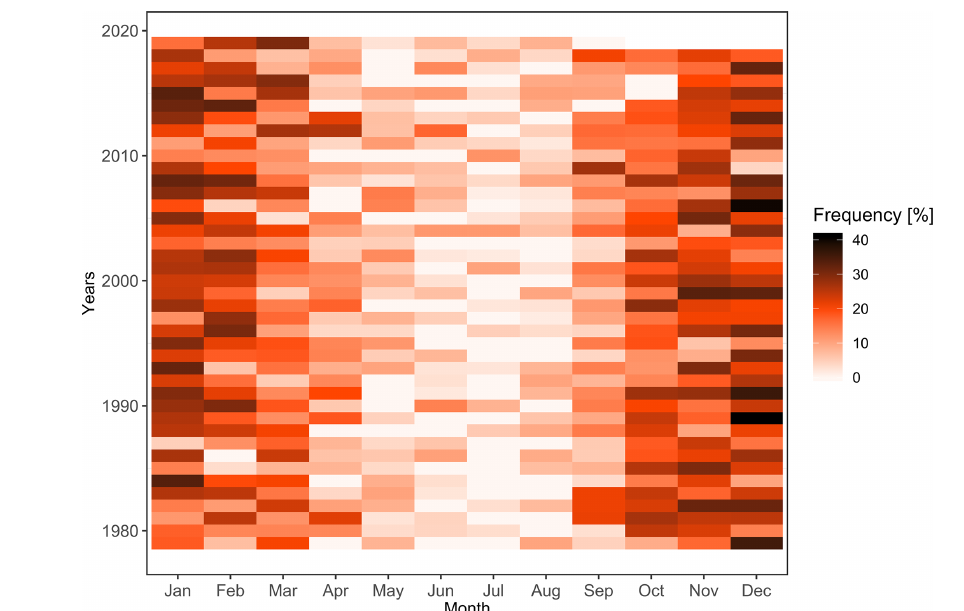
Figure A5. Monthly fraction of compound hazard clusters among the total number of clusters (wind only + rain only + compound clusters) for that month for 1979–2019 over the study area. Each tile represents a month–year pair; darker tiles mean that the fraction of compound hazard clusters is